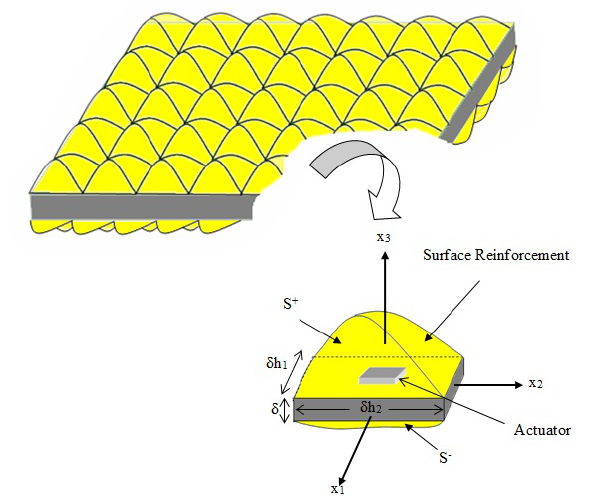
Figure 1: Thin smart composite plate with rapidly varying thickness and its periodicity